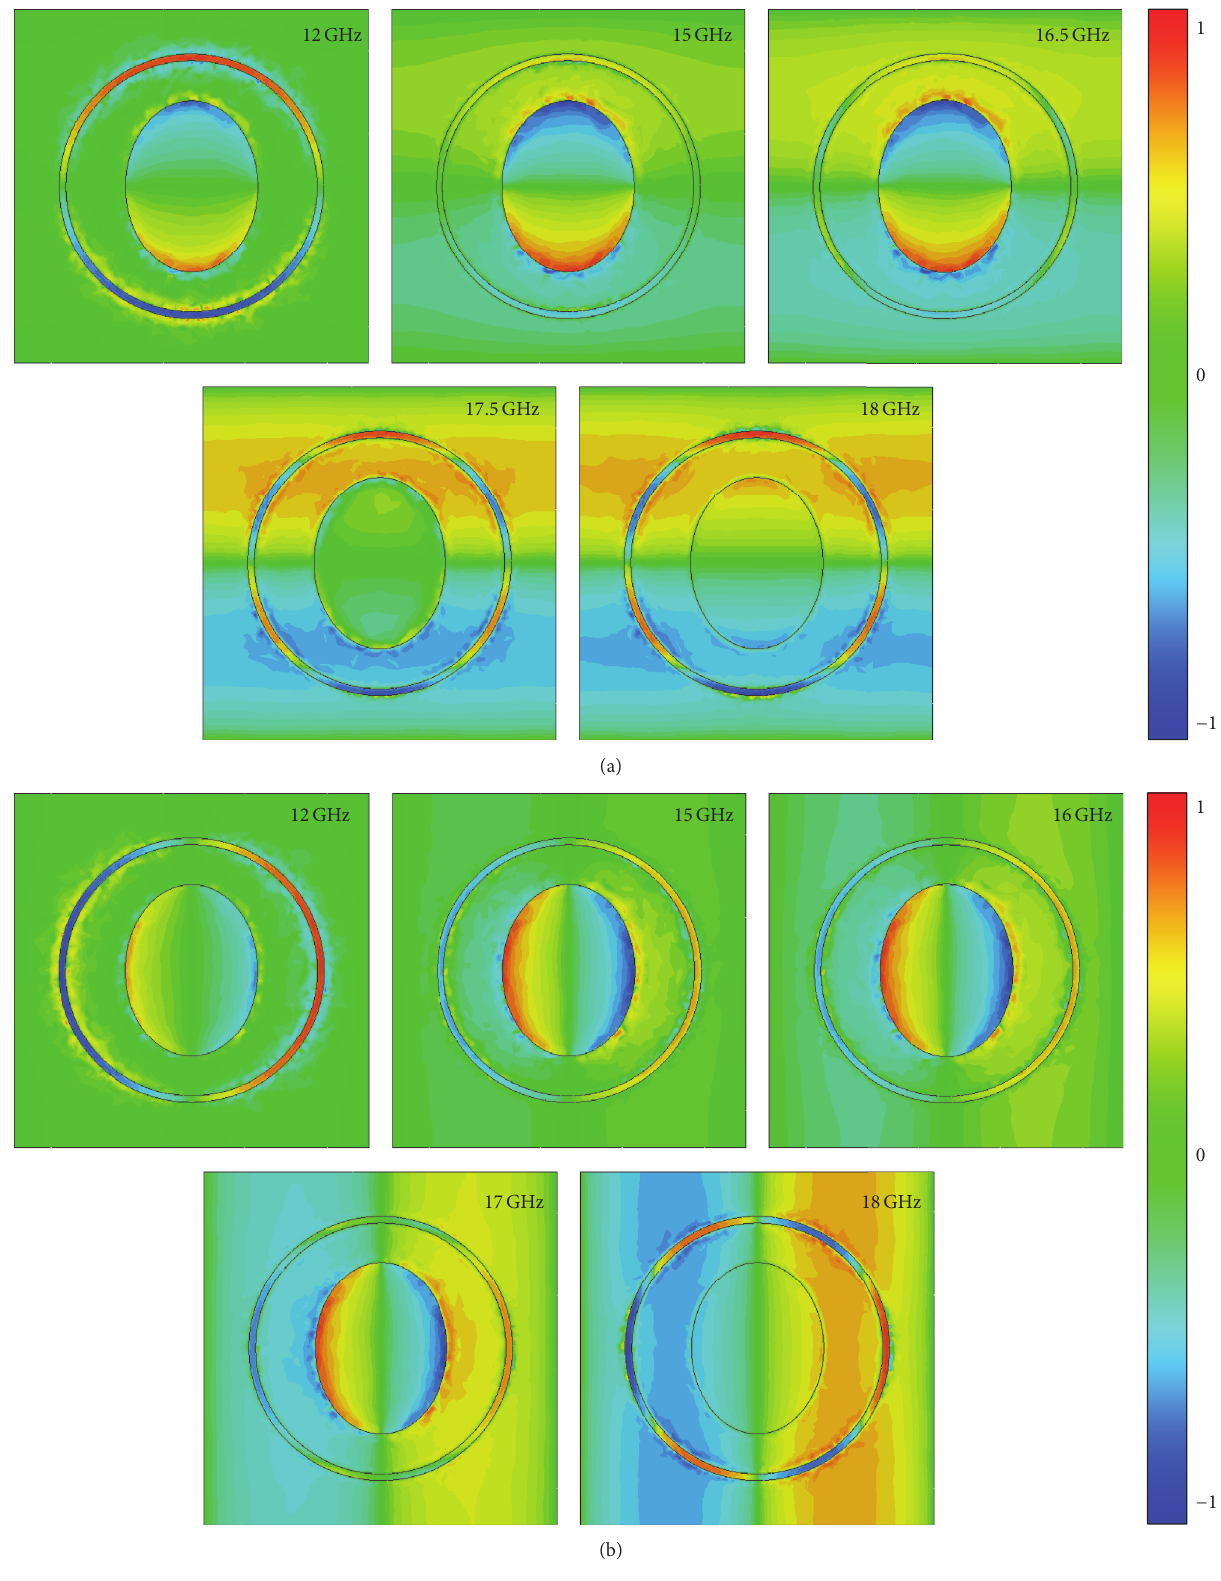
Figure 3: The resonances in the ring/disk cavity: (a) under major axis polarized incidence; (b) under minor axis polarized